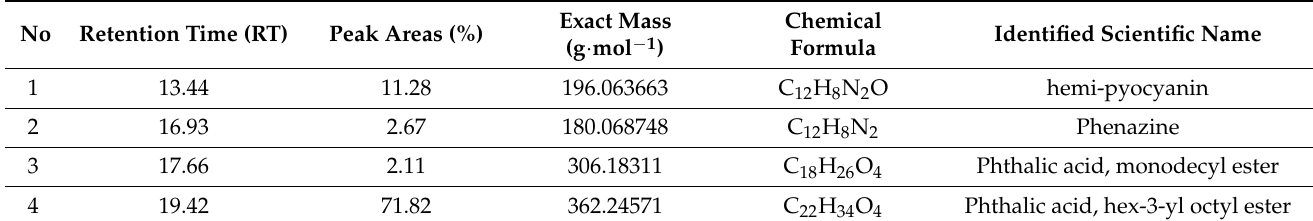
Table 3. The major compounds in the crude pigments produced by P. aeruginosa